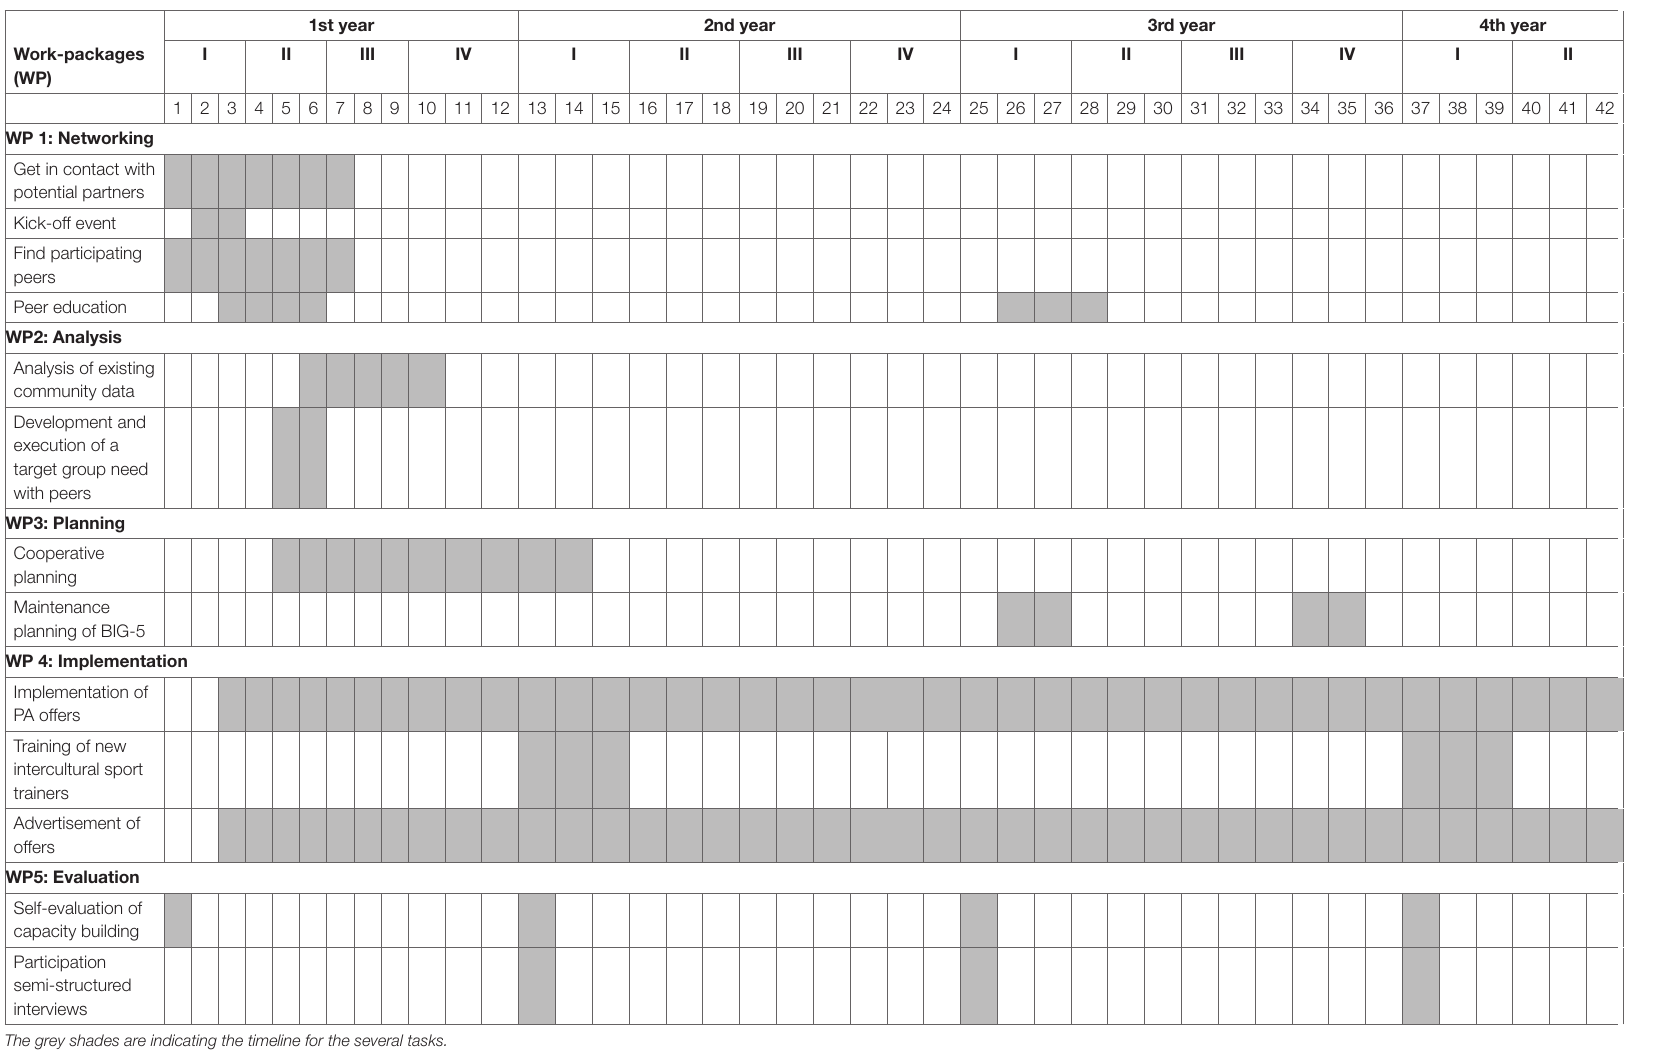
TABLE 1 | BIG-5 timeline of the project implementation by coordinators.